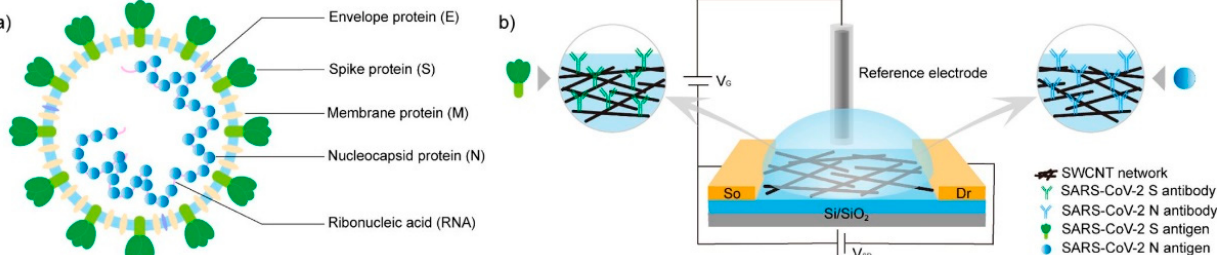
Figure 18. FET immunosensor for SARS-CoV-2 detection in nasopharyngeal samples. ( a ) Schematic structure of the SARS-CoV-2 viral particle. ( b ) Single-walled carbon NTs are functionalized with spike- or nucleoprotein-specific antibodies and placed on Au microchannels. Clinical samples can be applied onto the device to reveal both the spike and nucleoprotein antigens within 5 min through current and voltametric measurements. Image adapted from [122] with permission of American Chemical Society, 2021.